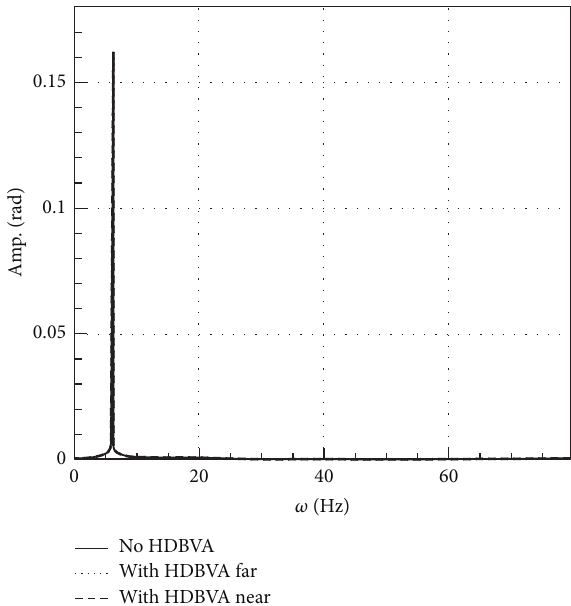
Figure 9: Numerical results of frequency response in 𝜃 𝑍 DOF with lateral groove.